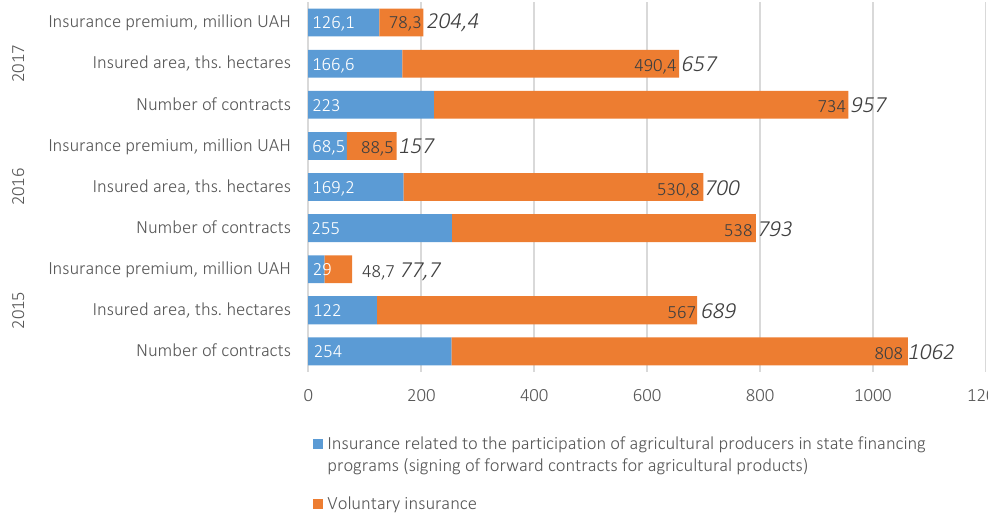
Figure 6. Indicators of the Ukrainian market of agricultural insurance in the context of